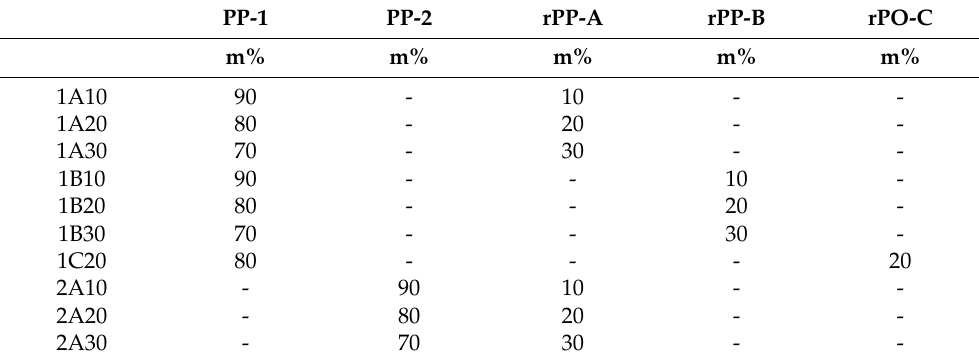
Table 1. List of compounds and their respective amounts of blending partners. To all compounds, additional 0.15 m% Irganox ® 1010 long-term stabilizer [20] and 0.15 m% Irgafos ® 168 processing stabilizer [21] were added during